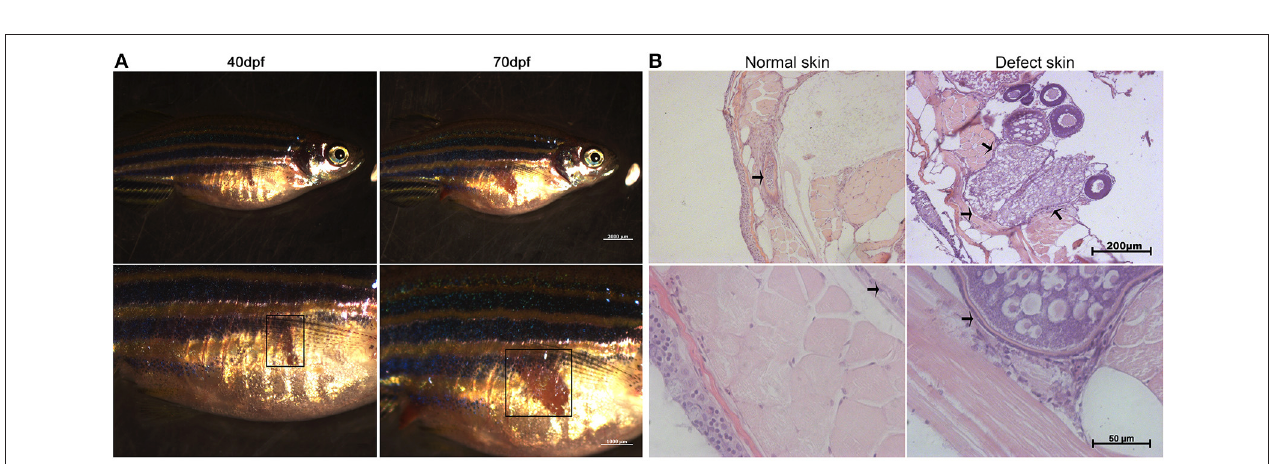
FIGURE 2 | A skin developmental defect of the female F1 generation of TFD zebrafish. (A) The phenotypes of the F1 generation showed different sizes developmental defect. Scale bars, 2,000 and 1,000 µ m. Black boxes represent the region of defect skin. (B) The normal and defect skin from the same F1 TFD fish. The patch and defect tissue adherent to the ovary were marked by square or arrows. Scale bars, 200 and 50 µ m.